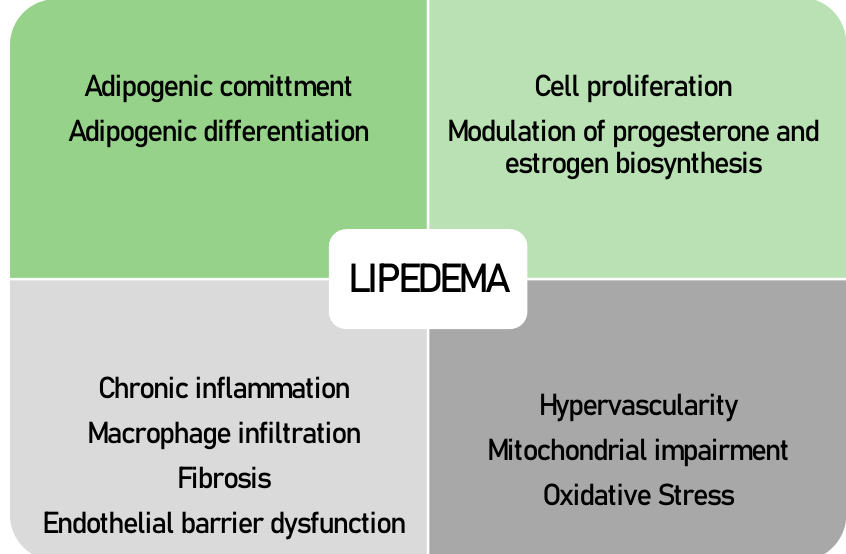
Figure 1. Biological processes suggested to be affected in lipedema pathology, as evidenced by data from ex vivo and in vitro research.